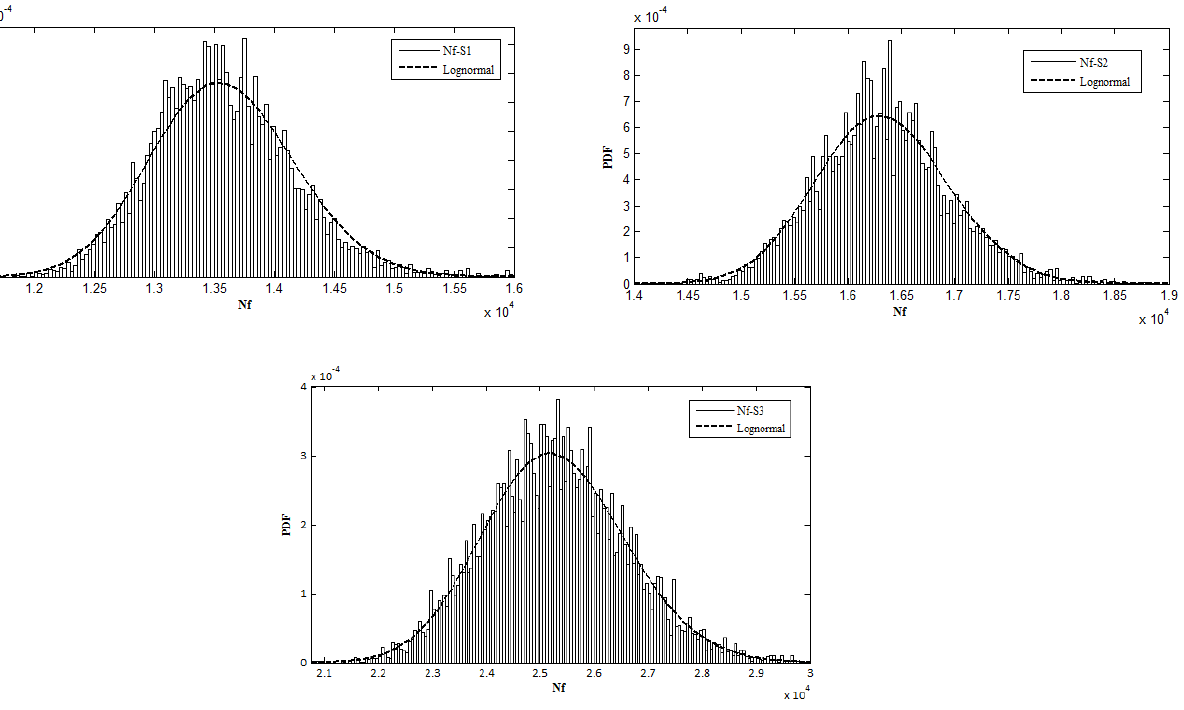
Figure 6. Estimated PDF of failure load cycles. Table 3. Statistical parameters of the estimated failure load cycles.